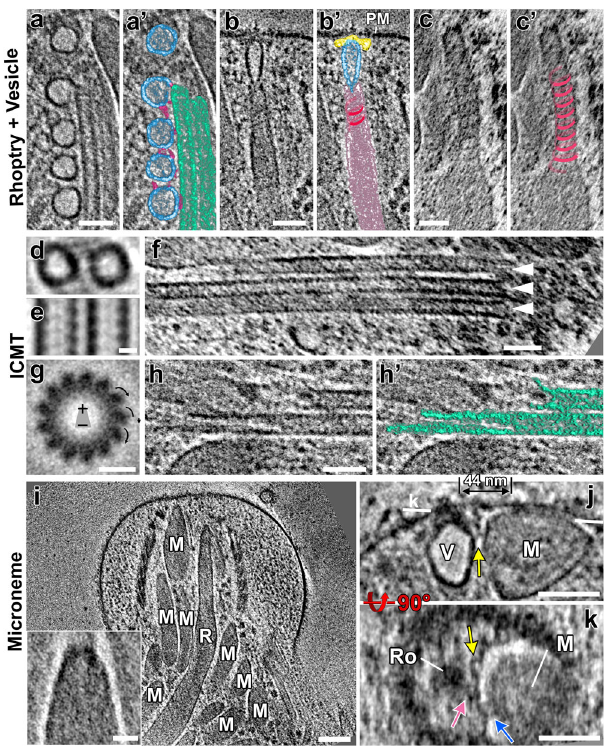
Fig.7|Theintraconoidalmicrotubulesandfunctionalsegregationofsecretory organelles within the conoid complex revealed by cryo-FIB milling and cryo- ET. a – c ’ Tomographic slices ( a – c : original; a ’– c ’ : pseudo-colored) show: ( a , a ’ ) fi ve regularly spaced vesicles (light blue), of which four are tracking along one of the microtubulesoftheICMT(lightgreen)andareconnectedbyinter-vesicularlinkers (pink); ( b , b ’ ) a rhoptry (rose) interacting with the plasma membrane (PM) via the most-apical vesicle (light blue) and the “ rosette ” docking complex (yellow); and ( c , c ’ ) a spiraling scaffold (dark rose) associated with the rhoptry membrane in the rhoptry-neck region. d , e Slices of the subtomogram averaged 8-nm repeats ofthe ICMTs viewed in cross-sectional ( d ) and longitudinal ( e ) orientations. f Occasionally, more than two microtubules were observed in the ICMT complex. Shown here is an example of three microtubules (white arrowheads). g Thirteen- fold rotationally averaged ICMT from 53 subtomograms of detergent-extracted Toxoplasma cells. The arrows indicate the clockwise skew of the proto fi laments when the ICMT are viewed from apical to basal, indicating that the minus ends of the ICMTs are oriented apically in the parasite. h , h ’ The basal ends of the ICMTs showed fl ared ends and different lengths of proto fi laments, which is usually asso- ciatedwithdynamicplus-endsofMTs. i Atomographicsliceofaprotrudedconoid shows the organization of micronemes. Insert: the subtomogram average of 25 microneme apical tips shows a fl attened, electron-dense cap. j , k Tomographic slices provide a side ( j ) and a top cross-sectional view ( k ) of two secretory orga- nelles, a microneme (M) and a rhoptry-associated vesicle (V),thataredocked side- by-side to the plasma membrane (the vesicle through the rosette (Ro)), but with distinct docking sites (44nm apart). Note that both organelles are tethered (pink and blue arrows) to the same plasma membrane-anchored ridge (yellow arrows). Thewhitelinein( j )indicatesthelocationoftheslicein( k ).Scalebars:100nm(in I ); 50nm (in a – c , f , h , j , k ); 20nm (in i insert), 10nm (in d , e , g